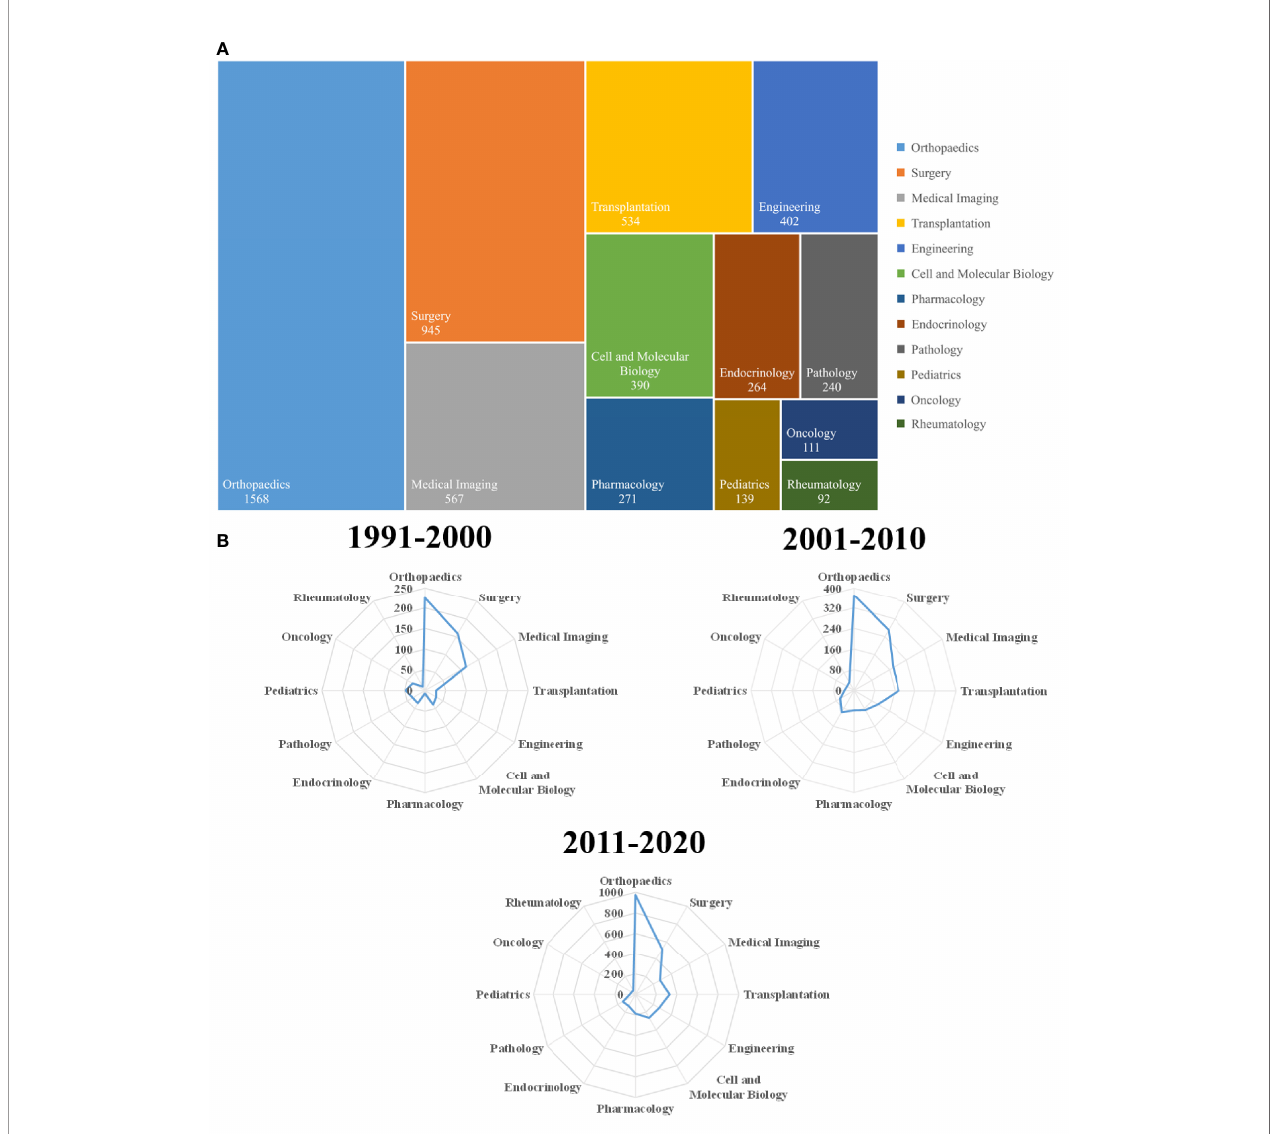
FIGURE 4 | Research area analysis of global publications in ONFH in the last 30 years. (A) Research areas in ONFH. (B) Radar map of research areas in ONFH during 1991-2000, 2001-2010 and